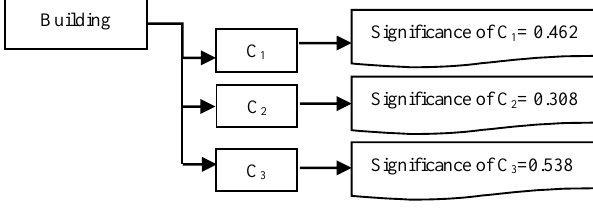
Figure 1.Hierarchy of semantic levels based on the significance of C 1 , C 2 , and C